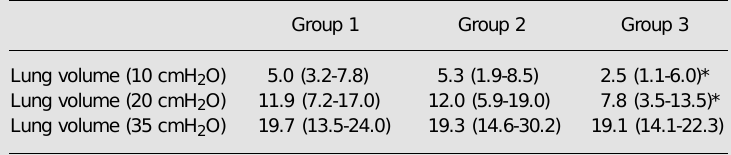
Table 2. Lung volumes (ml) at pulmonary pressures of 10, 20, and 35 cmH 2 O.